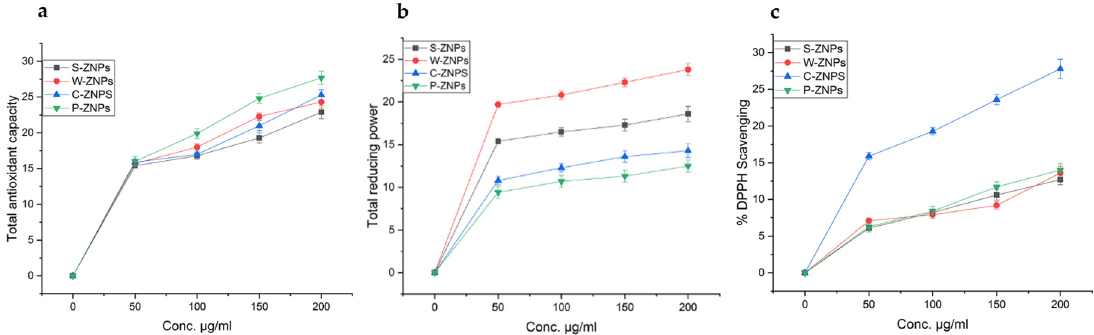
Figure 6. Total antioxidant capacity (TAC) ( a ), total reducing power (TRP) ( b ) and DPPH-free radical scavenging assay (FRSA) ( c ) potential of the biosynthesized ZnO NPs. The experiments were carried out in triplicate. The values given in figure are mean ± standard deviation of the original data.